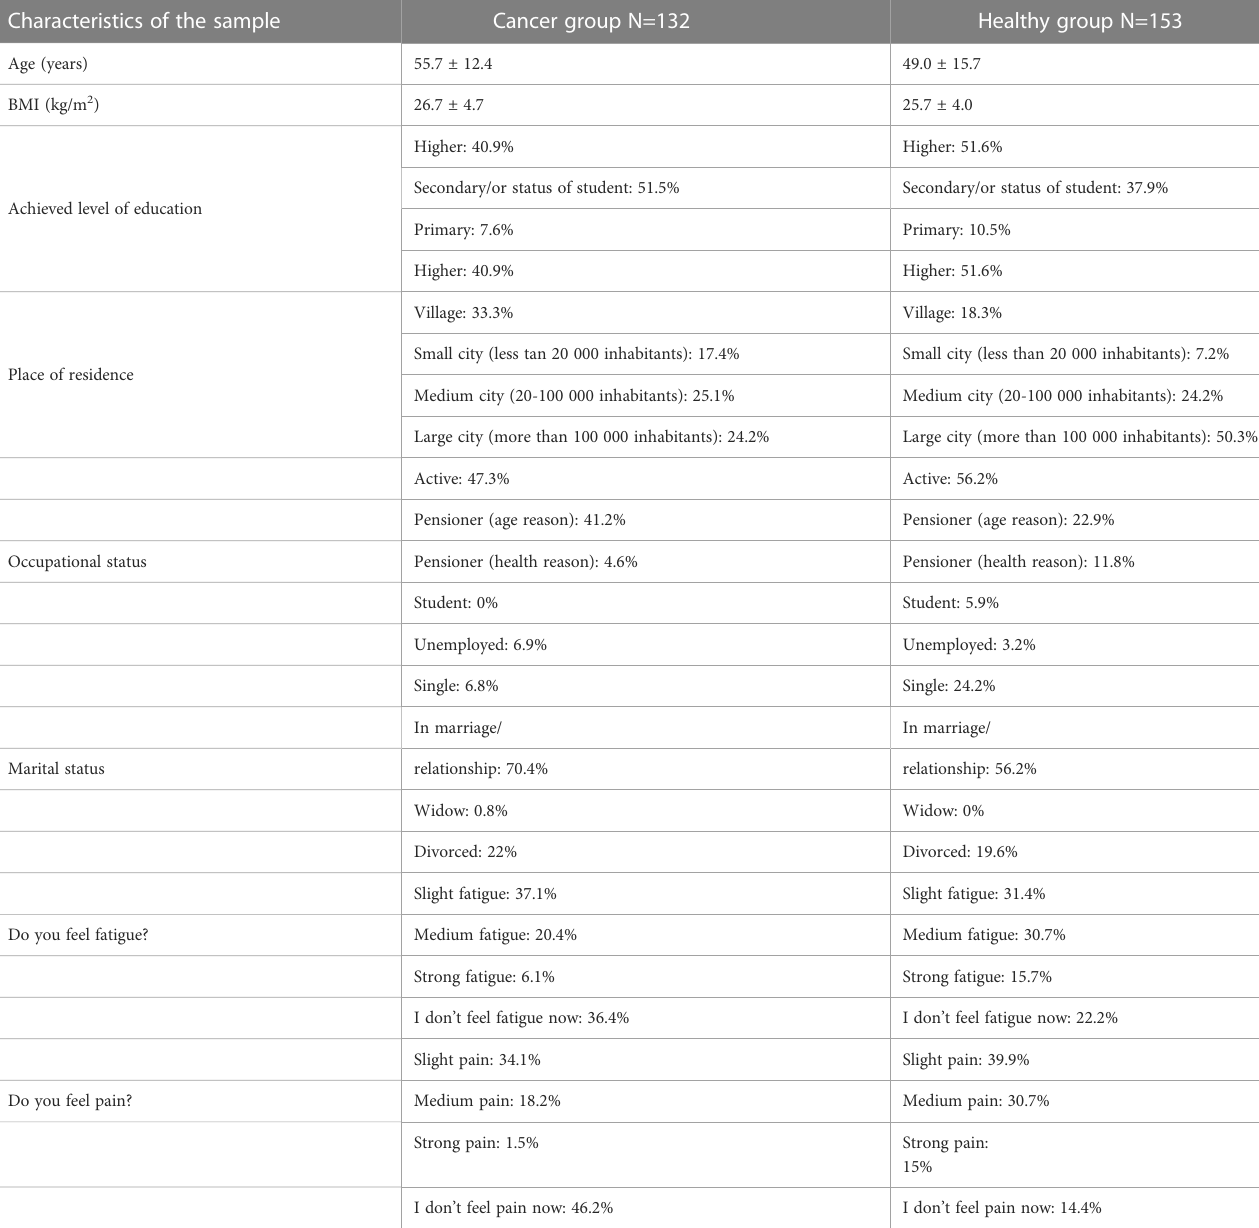
TABLE 1 Characteristics of the surveyed women (N=285) – women with BC (N=132) and control group (N=153) – women without BC. Data is shown as mean ± standard deviation (SD) and percentages (%). Characteristics of the